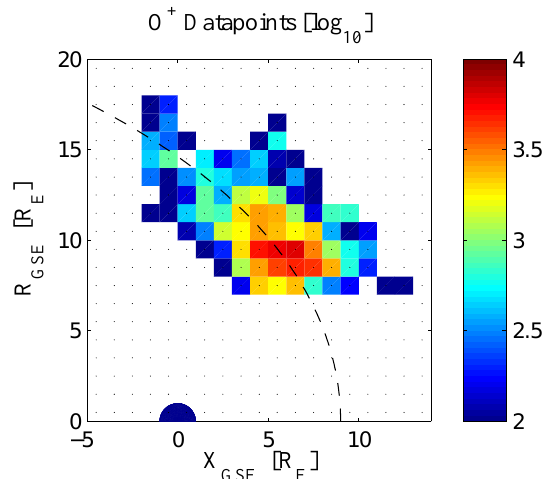
Figure 1. The spatial distribution of the magnetosheath O + data set, given in a cylindrical coordinate system with R GSE = (Y 2 Z 2 ) 1 / 2 . The colour bar corresponds to a logarithmic scale visu- GSE alizing the number of data points in 1 R E × 1 R E bins. Regions of no observations are left